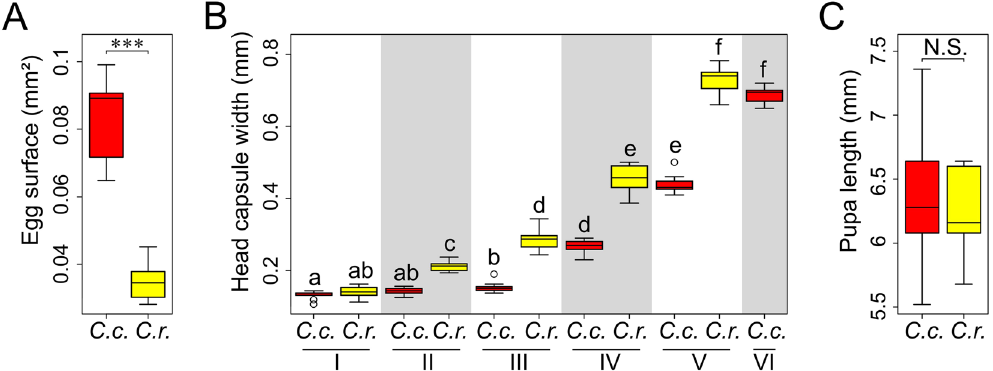
Figure 4. Boxplots showing insect size along development of Caloptilia cecidophora ( C . c ., in red) and its closely related non-gall-inducing species C . ryukyuensis . ( C . r ., in yellow) ( A ) Egg area. ( B ) Head capsule width of each larva instar, instars followed by a different letter have significantly different size (see Table S8). ( C ) Pupal length ( *** < 0.001, N.S.: no significant